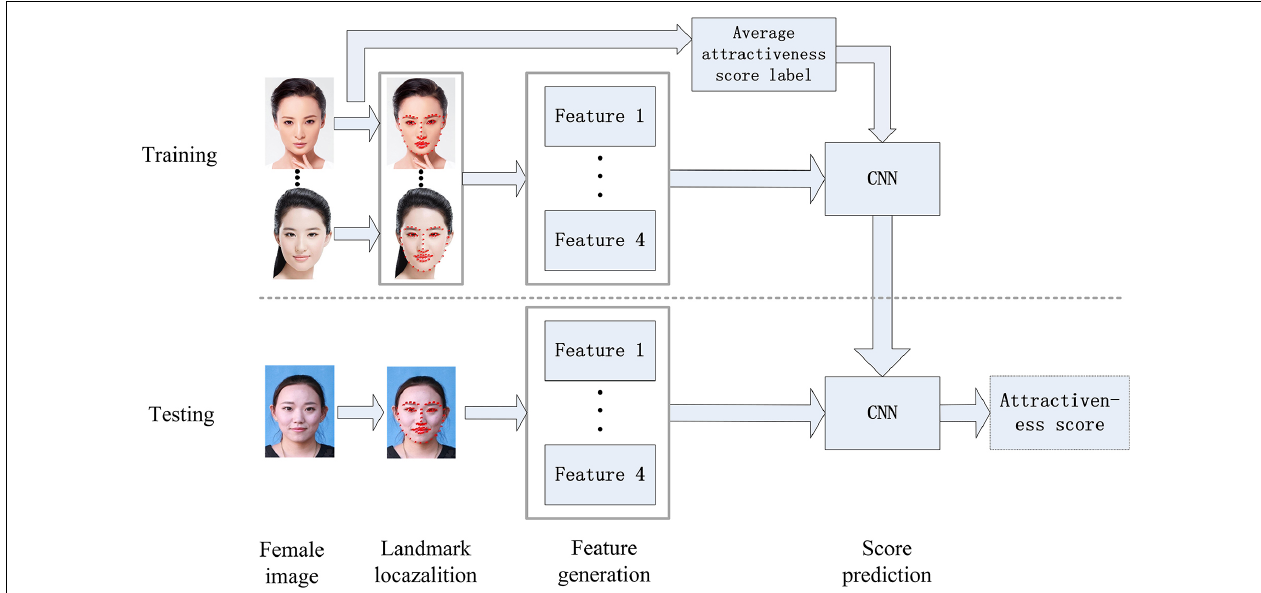
FIGURE 1 | Prediction process of facial attractiveness score (Clarification: the training images were obtained from the SCUT-FBP dataset, which is publicly available at http://www.hcii-lab.net/data/SCUT-FBP, written informed consent of the testing image was obtained from the individual for the publication).